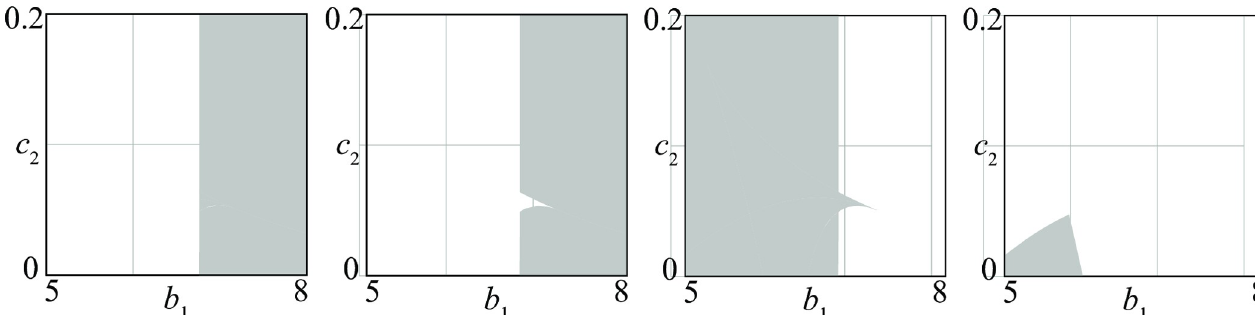
Fig 8. Four different sets of D—A conflicts (see text for their meanings).